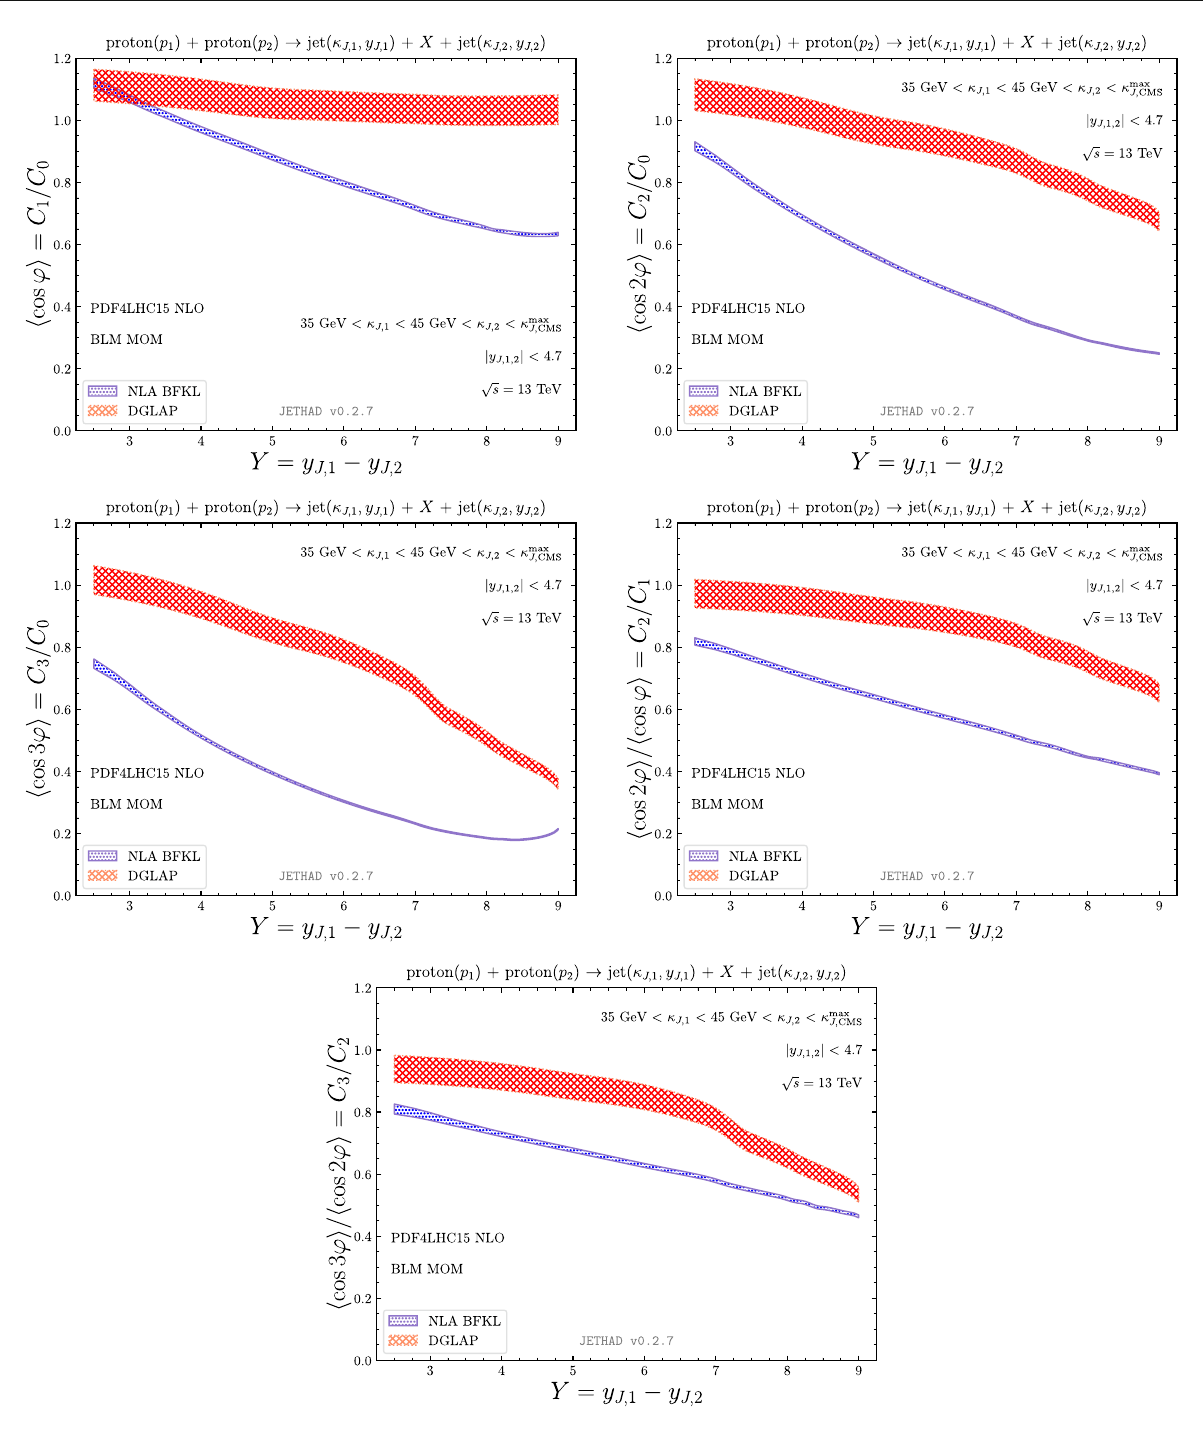
Fig. 11 Y -dependence of several azimuthal correlations, R nm ≡ C n / C m , of the Mueller–Navelet jet production (left panel of Fig. 2) √ s = 13 TeV ( asymmetric CMS config- for μ F 1 , 2 = μ R = μ BLM and R